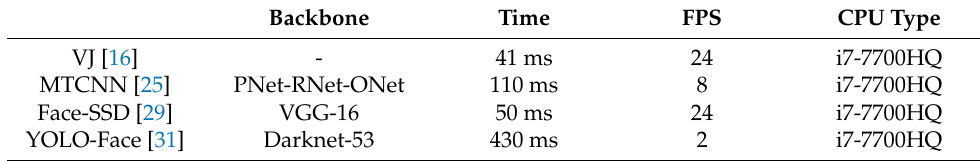
Table 6. Time comparison between different face detection methods for VGA images on